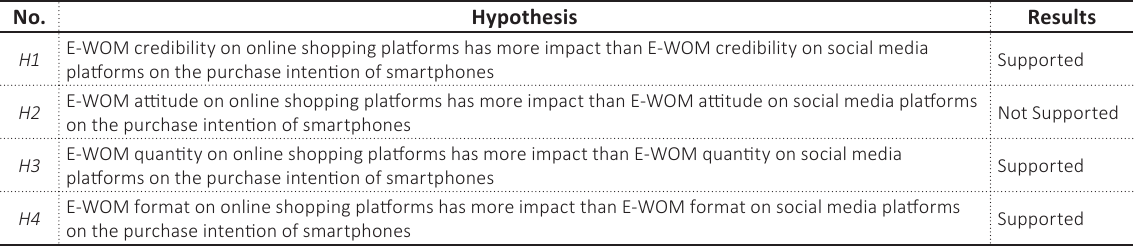
Table 6. Results of hypothesis testing No. Hypothesis